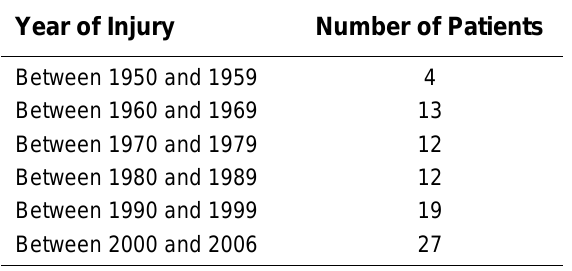
Year of Injury of Spinal Cord Injury Patients, Group 1